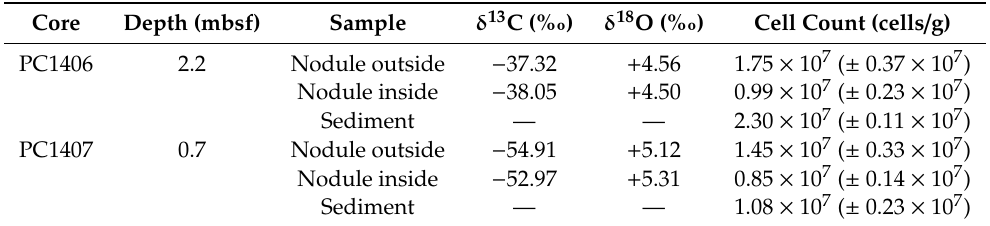
Table 1. Carbon and oxygen isotopic compositions and microbial cell abundance of carbonate nodules collected from piston cores.